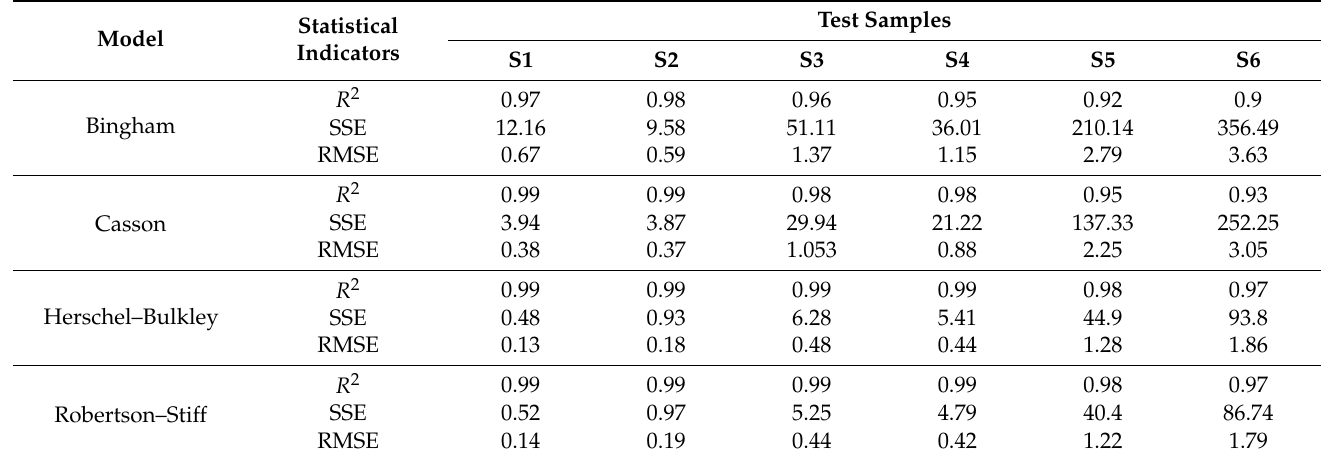
Table 3. Statistical